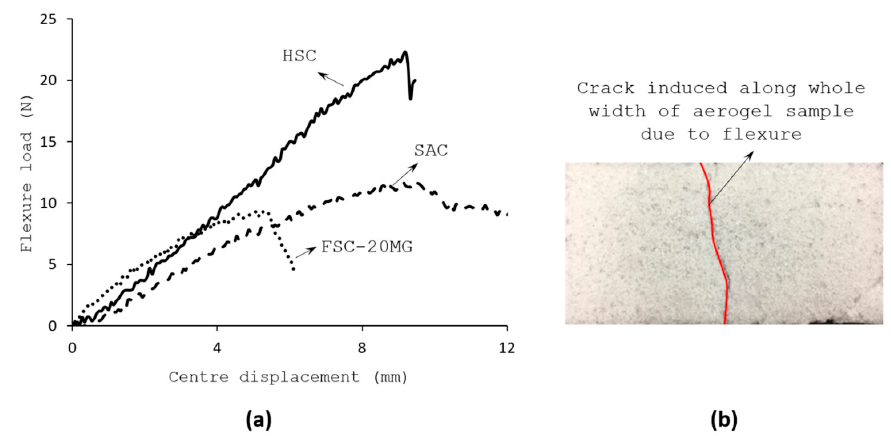
Figure 7. Results of three-point flexure test ( a ) Load-displacement curve ( b ) Tensile crack visible on bottom surface of aerogel composite.